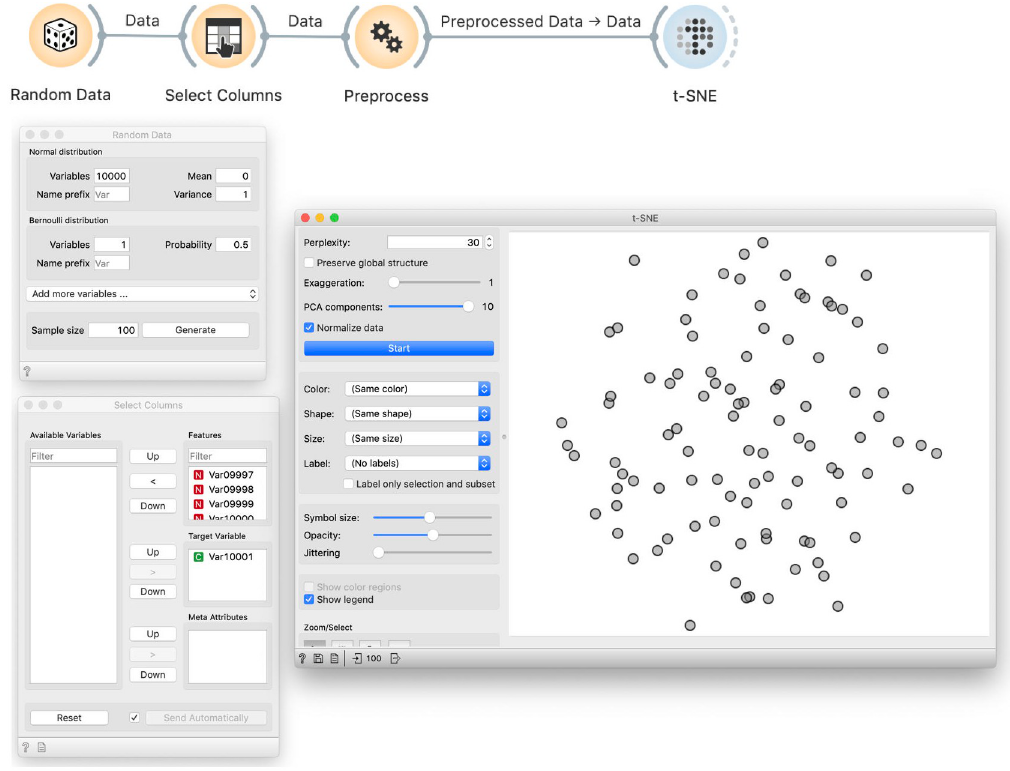
Fig 11. t -SNE visualisation of a random data. We generate 10,000 normally distributed random variables and one Bernoulli variable, which we designate as the target variable. In Preprocess, we choose ten variables that are most correlated with the target. This data is then used in the t -SNE visualisation. In this particular visualisation, the value of the target variable is not shown, and the dots in the t-SNE visualisation representing the data set items seem to placed randomly, as expected, and do not expose any clustering